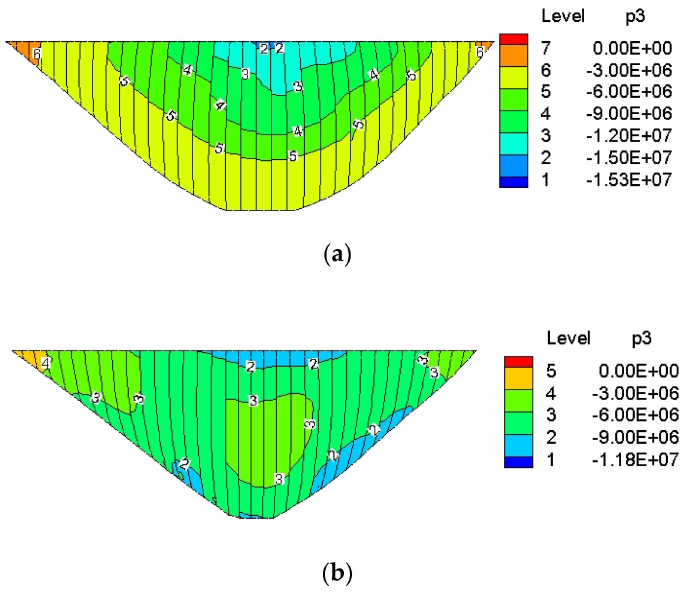
Figure 5. Envelopes of maximum compressive principal stresses using the new standard (Pa). ( a ) Upstream surface and ( b ) downstream surface.